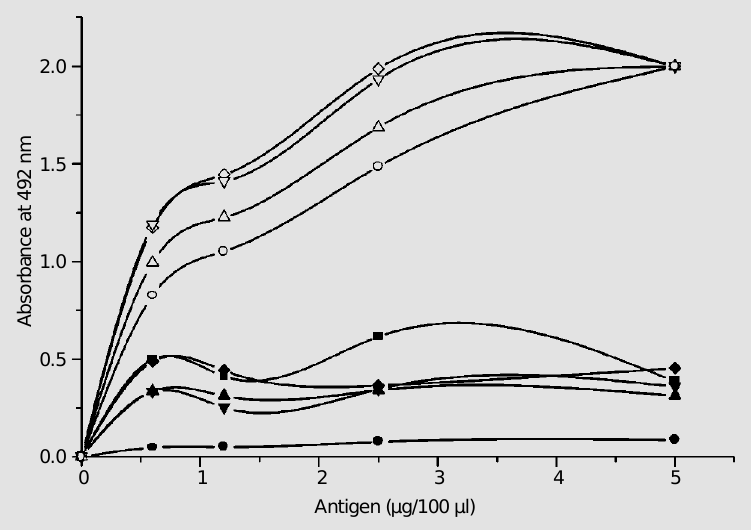
Figure 1. Relation between F1 antigen and titration of immune and non-immune rabbit serum in ELISA using polysiloxane-PVA-glutaraldehyde discs. Titration of immune serum diluted 1:100 (open lozenges), 1:200 (open inverted triangles), 1:400 (open triangles), and 1:800 (open circles). Titration of non-immune serum diluted 1:100 (filled squares), 1:200 (filled lozenges), 1:400 (filled inverted triangles), and 1:800 (filled triangles). Control - PBS (filled